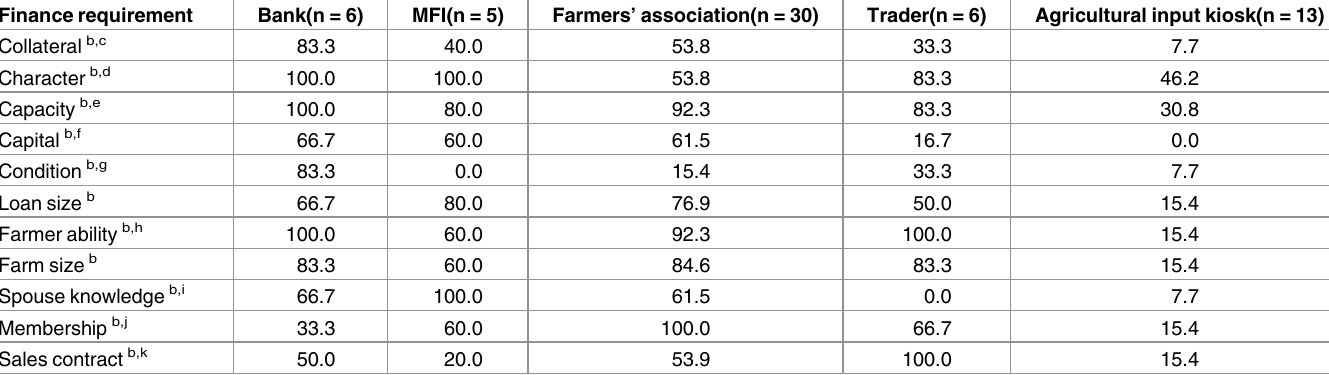
Table 2. Important finance requirements from the perspective of different finance provider types a